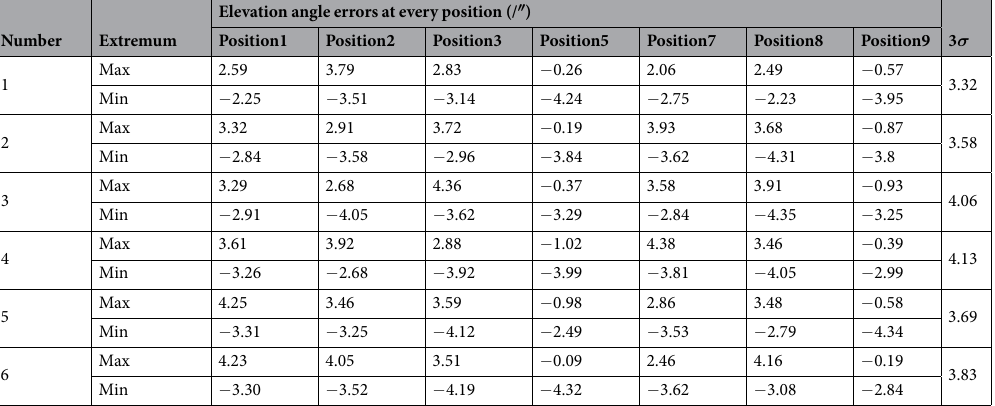
Table 4. The elevation angle errors of static precision evaluation.